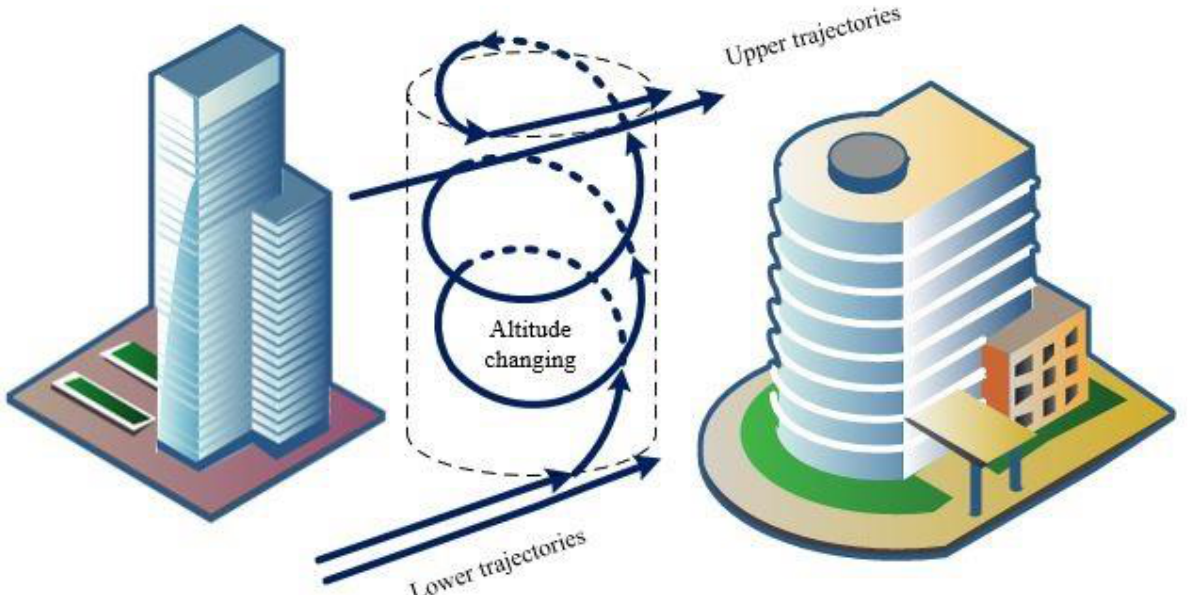
Figure 5. Sector for “vertical motion”, changing the flight altitude .